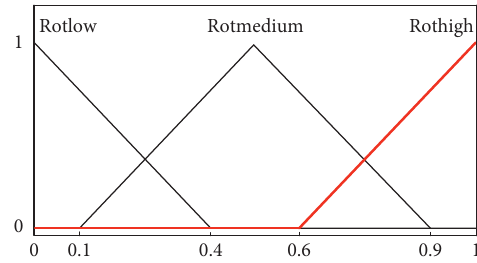
Figure 18: FV membership functions for LV εr : “angular